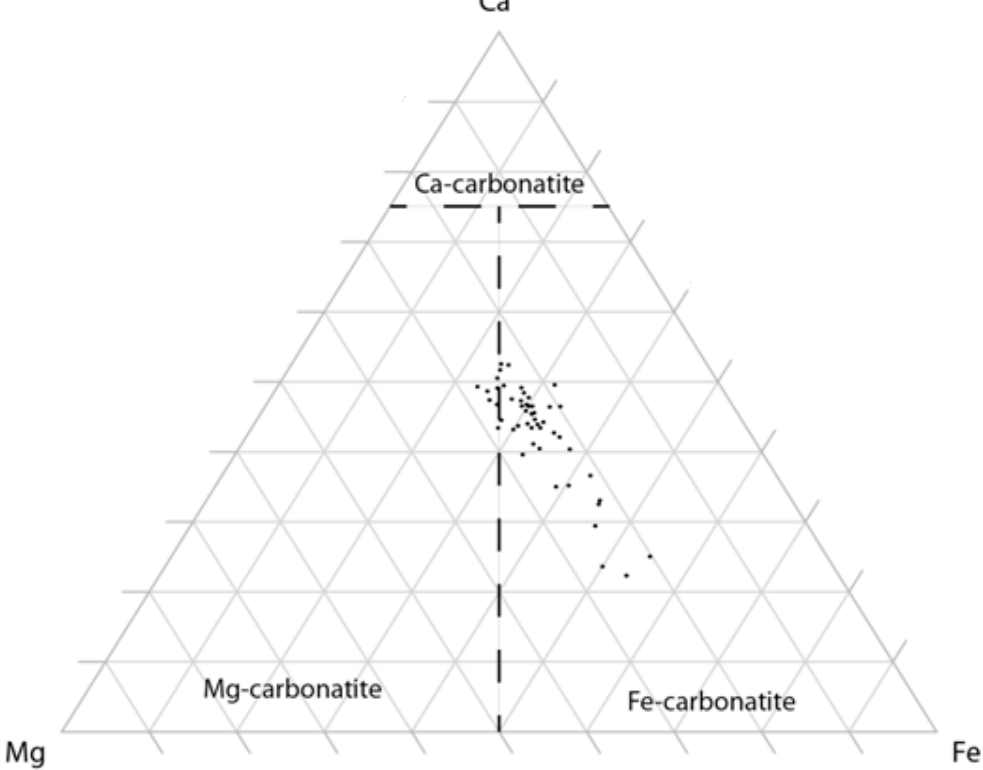
Figure 6. Mg–Ca–Fe classification diagram of ferro-carbonatite [58] for Saint-Honoré REE deposit samples (Table S1 some points overlap).